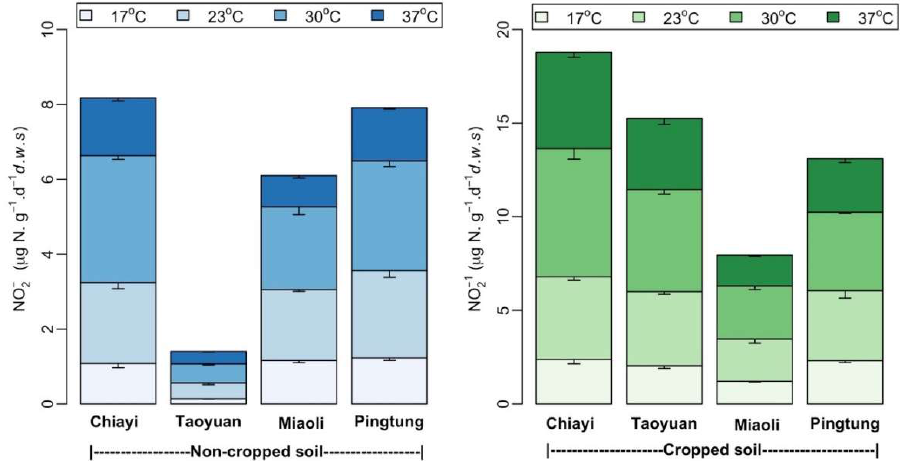
Figure 1. Soil nitrification potential among different cropped and non-cropped soils over a temperature gradient. Bars represent means (± standard error of mean) for three replications.